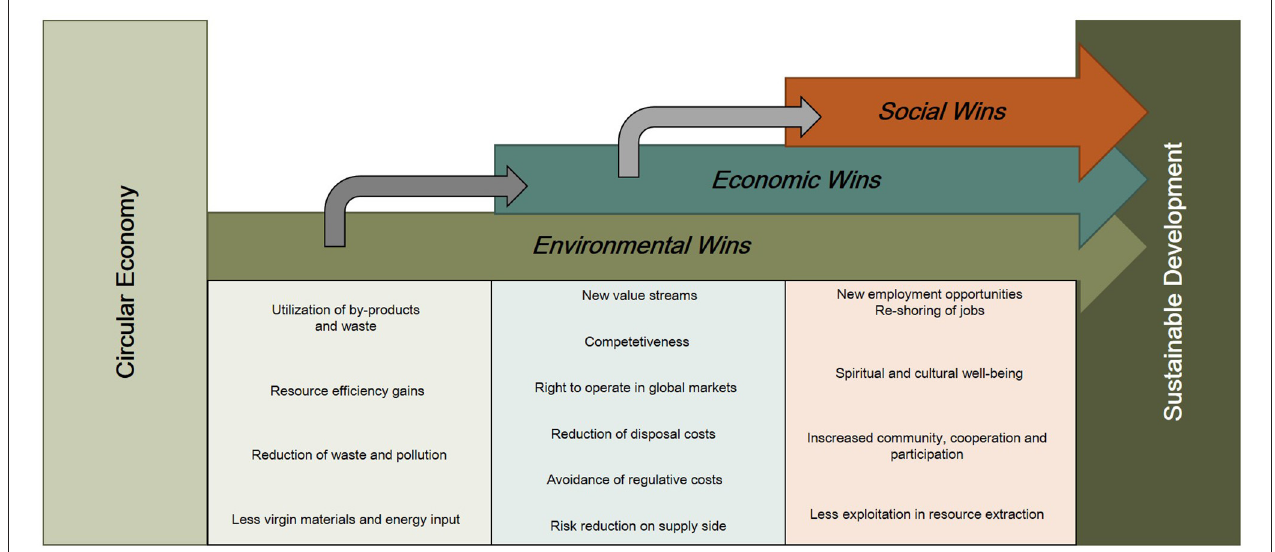
FIGURE 2 | Circular economy’s contribution to sustainable development (in accordance with Korhonen et al., 2018).